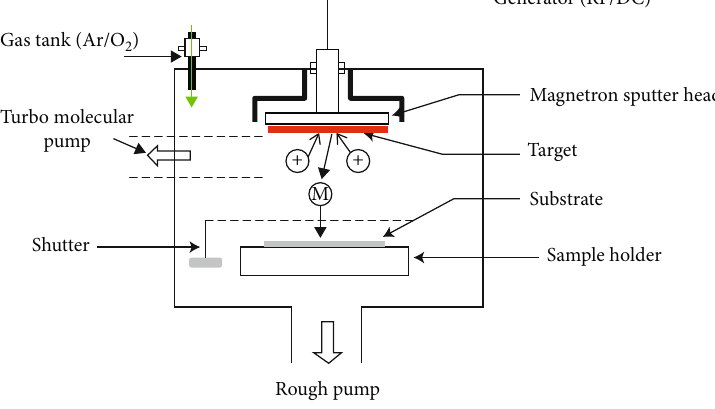
Figure 1: Sputtering rig. Table 1: Hardness values of DLC